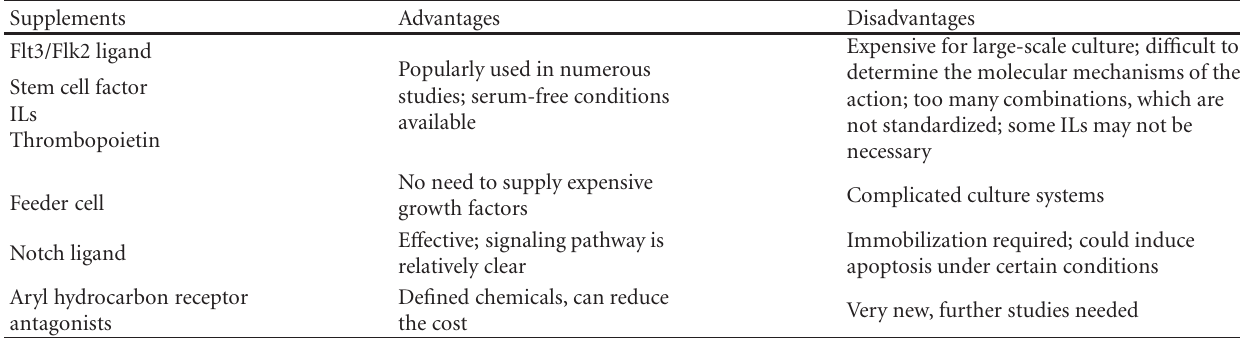
Table 1: Summary of culture supplements used for